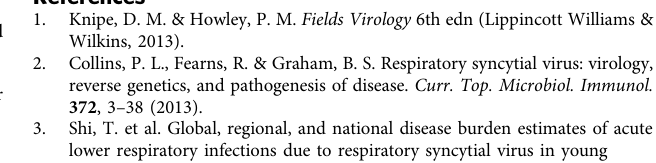
Figure preparation . All the fi gures representing model and electron density maps were generated using COOT 74 , UCSF Chimera 73 , and PyMOL 80 . Multiple sequence alignments were performed using Multalin 81 and ESPript 82